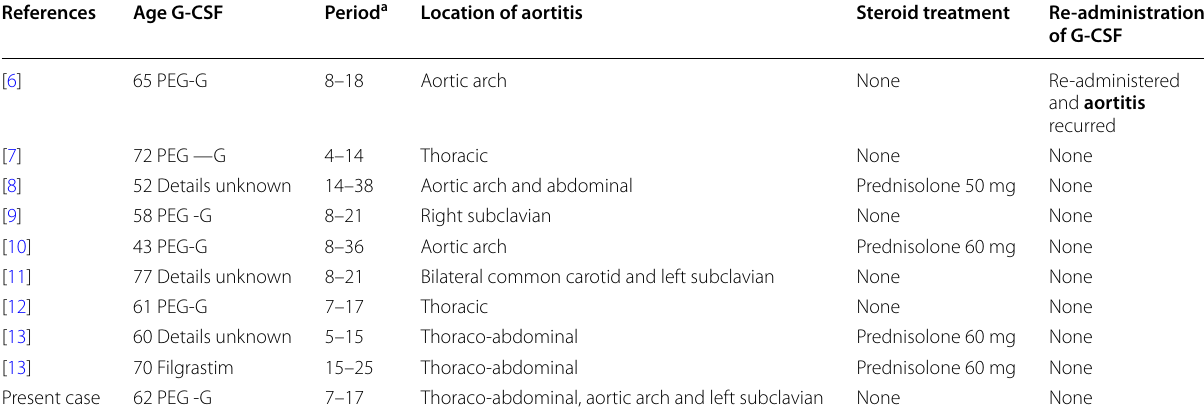
Table 3 Reported cases of G-CSF-associated aortitis in recent years